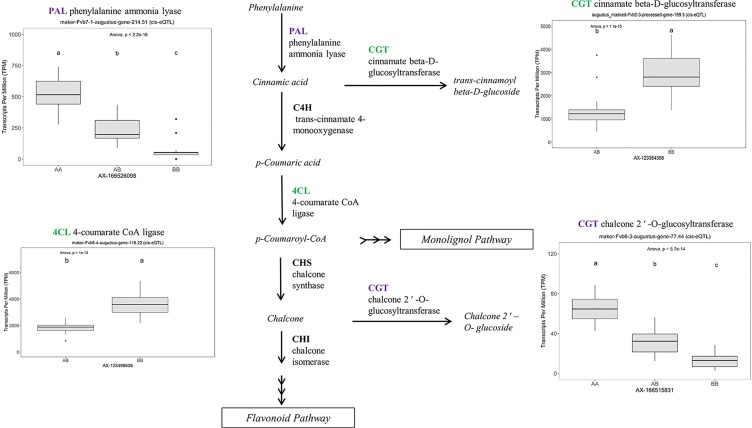
eQTL controlling transcript accumulation of key genes in the strawberry phenylpropanoid pathway (PPP). Marker effect sizes are indicated by boxplots stratified by allelic state (AA, AB, or BB) and shown with ANOVA p-values. eQTL genes based on the ‘Camarosa’ genome are indicated as either possessing the highest sequence identity to the published sequence (purple) or not (green). Letters represent statistically separable means via Tukey’s HSD post hoc test (p < 0.05).